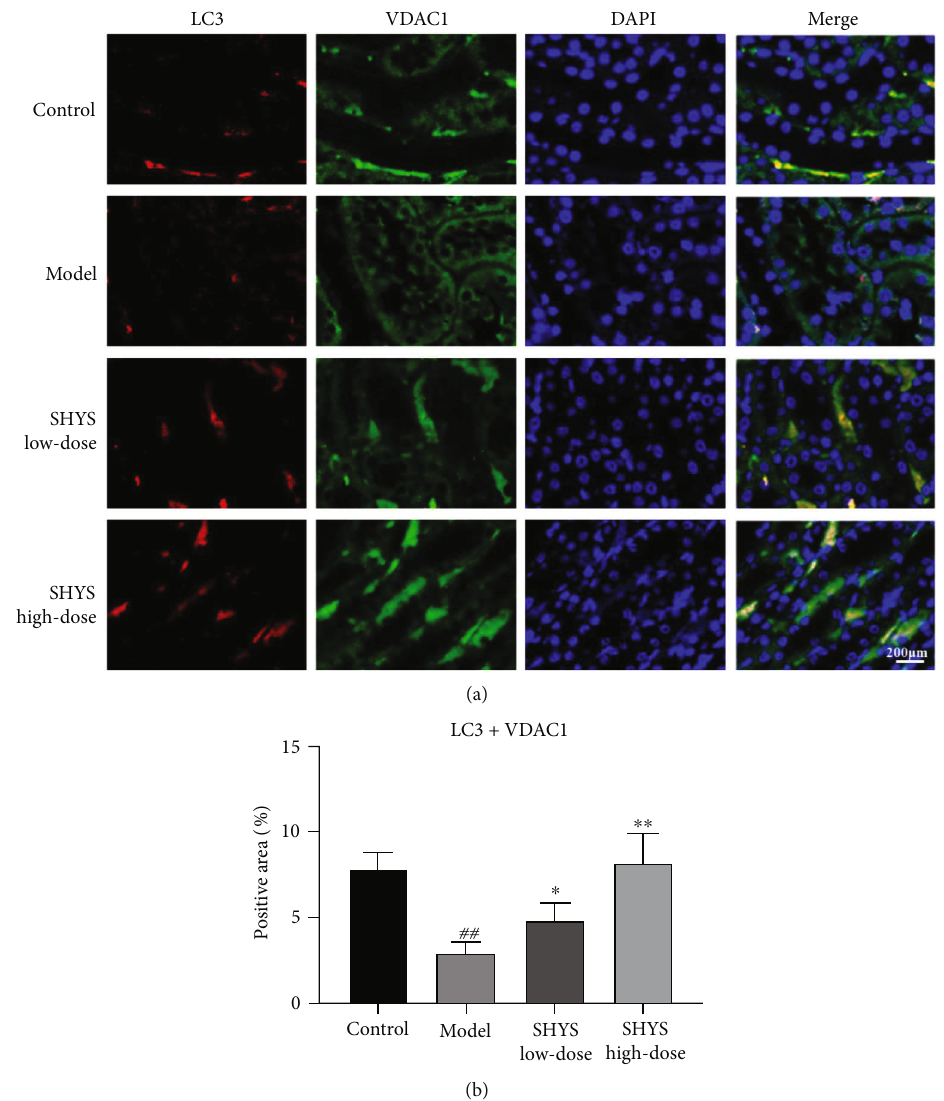
Figure 5: SHYS treatment increased the coexpression of LC3 and VDAC1 in DKD model rats. The coexpression of LC3 and VDAC1 in the kidney was investigated using immuno fl ourescence. (a) The mange of immuno fl ourescence staining in each group ( 400 × ). (b) Quantitative of immuno fl ourescence based on positive